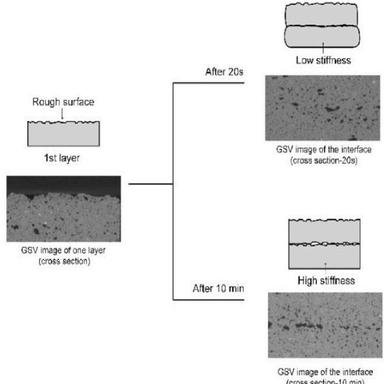
Illustration of air void formation induced by extending the time gap between layers, adapted from Ref..